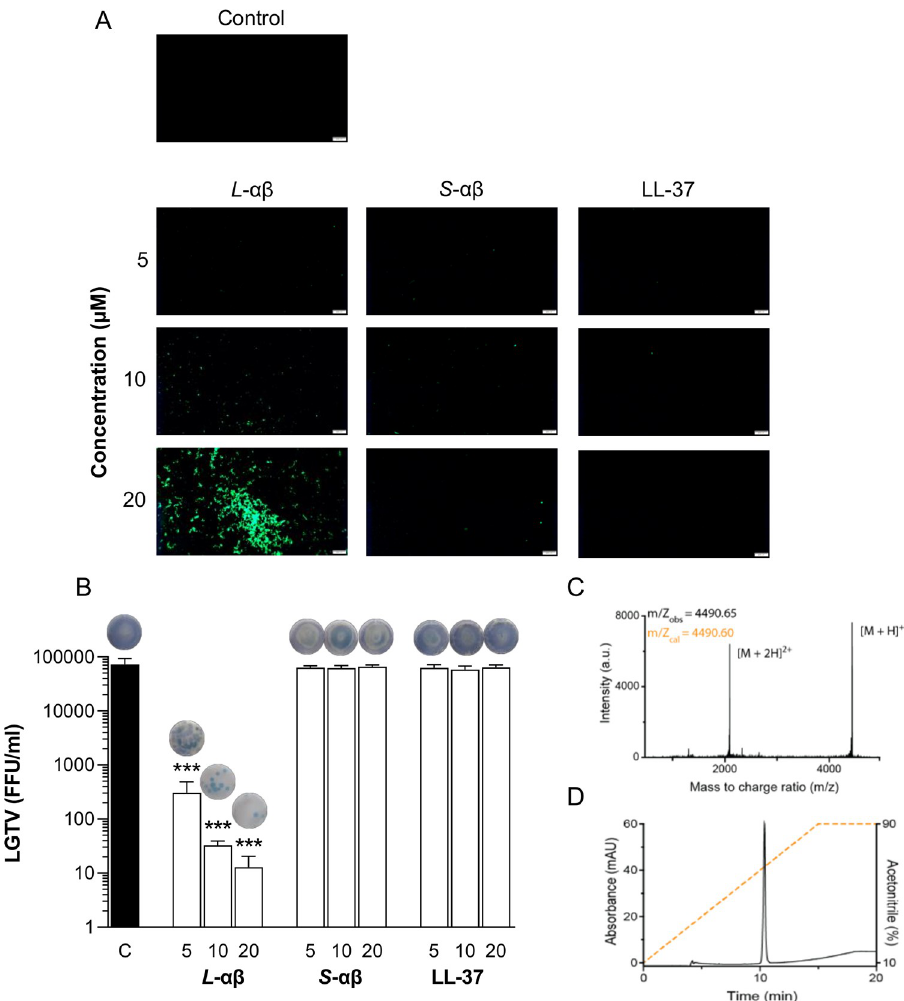
Fig 1. PLNC8 αβ , but not scrambled peptide or LL-37, is effective against flaviviruses. LGTV (1 × 10 5 ), suspended in DMEM, were either left untreated or exposed to L -PLNC8 αβ (L- αβ , 1:1), S -PLNC8 αβ (S- αβ , 1:1) or LL-37 at a final concentration of 5, 10 and 20 μ M. A- The samples were fixed with 4% PFA for 2 h followed by addition of Sytox Green for 5 min, and images were captured with Olympus BX41 at 40 × magnification. Scale bar is 200 μ m. B- LGTV was incubated in cell culture media containing the indicated concentrations of L -PLNC8 αβ , S -PLNC8 αβ or LL-37 for 1 h at 37˚C. The suspension was then added to Vero cells and incubated for 1 h. An overlay media was casted onto the cells and the plates were incubated for 3 days. Viral load was quantified by performing immunofocus-based plaque assay. The indicated concentrations are in μ M. Representative images of the virus plaques are presented above the bars. The virus particles are rapidly permeabilized by L -PLNC8 αβ , forming large aggregates, and decreased the viral load by > 99.9%. C - Peptide identity of the purified LL-37 was analyzed and confirmed with MALDI-ToF MS. D - The purity of LL-37 was confirmed by HPLC yielding a single peak. Orange dotted line indicates gradient of acetonitrile (10–90%) in H 2 O containing 0.1% TFA. The data (n = 4) are presented as mean with SEM and analysed using one-way ANOVA with Dunnett´s multiple comparison test ( ��� p < 0.001). The human cathelicidin-derived peptide LL-37 is a known antimicrobial peptide that was used as a control.